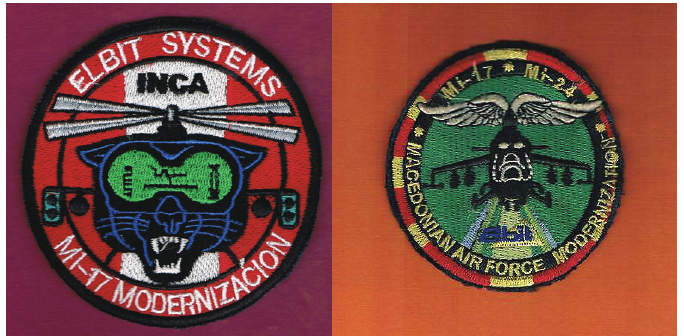
Figure 9 – Emblems of the Israeli company "Elbit Systems" during the modernization Рис . 9 – Эмблемы израильской компании "Elbit Systems" в течение модернизации Слика 9 – Амблеми израелске компаније „Elbit Sistemi’’ током